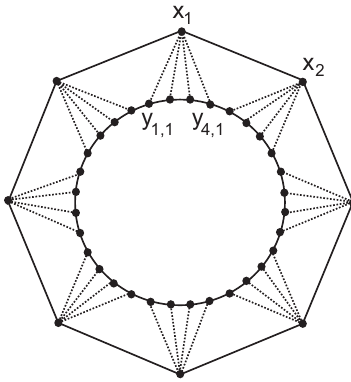
Fig. 1. Schematic illustrations of the L96 system with m =8 and n =4, with a total of m × n grid points in the inner